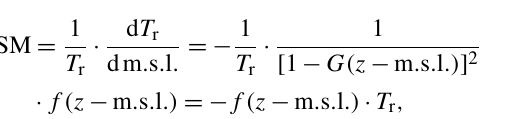
served (green line) and future (blue and red lines)